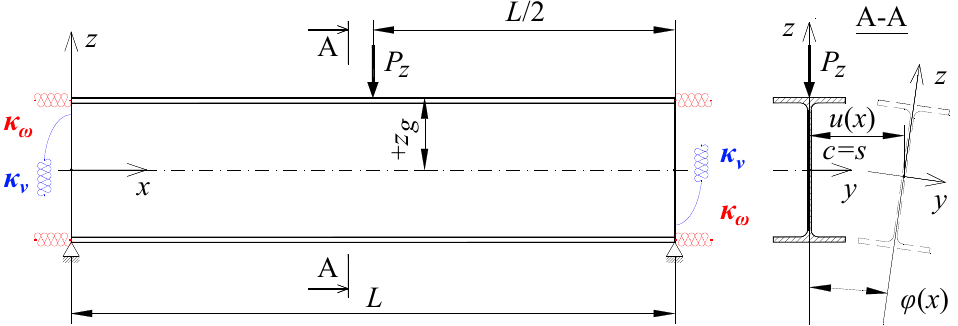
Figure 2. The static scheme of a beam elastically restrained in the support nodes ( κ ω , κ ν ) under the load of a force concentrated ( P z ) at the midspan.